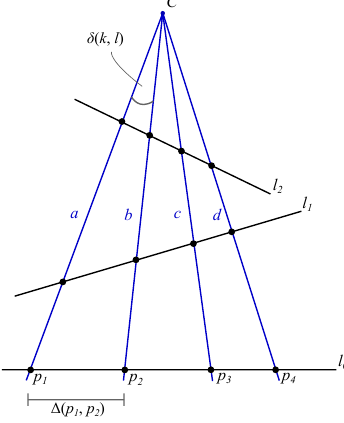
Figure 1. The cross-ratio between four collinear points is invariant under the perspective